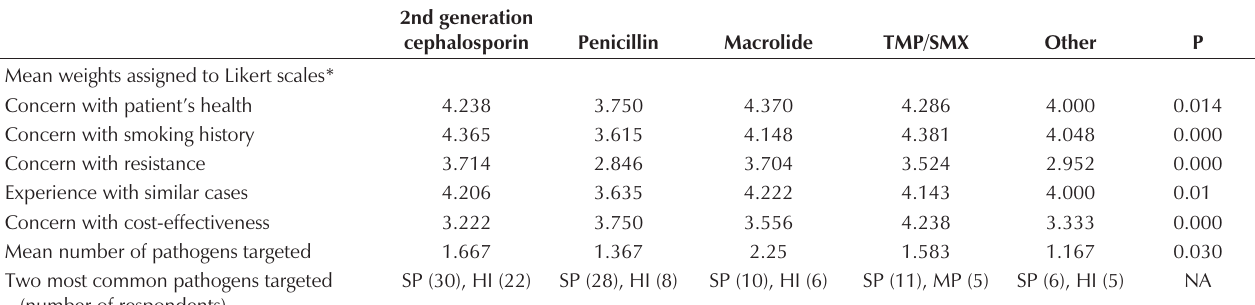
TABLE 4 Factors found to be significant correlates with respondent choice of antibiotic for case 2 – A 66-year-old male with comorbidity and nonsevere clinical